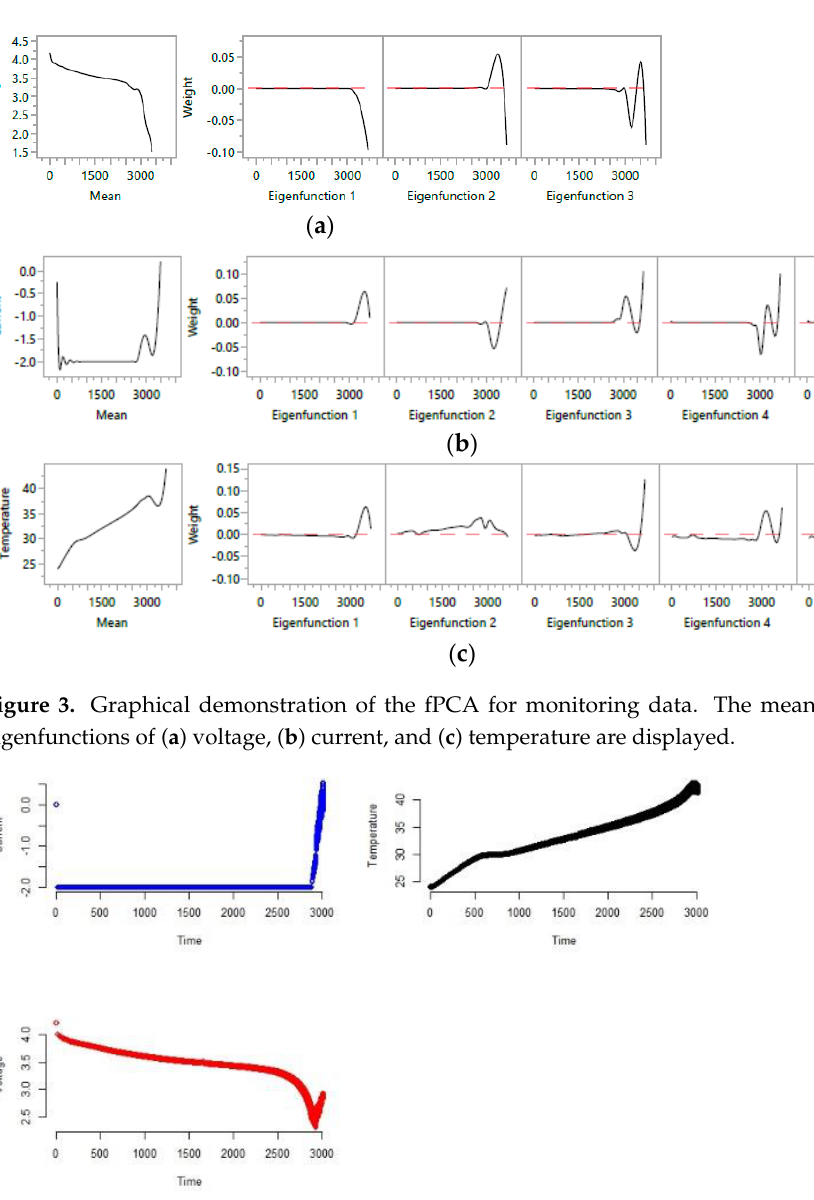
Figure 4. The predicted 20 forthcoming cycles of current, temperature, and voltage.